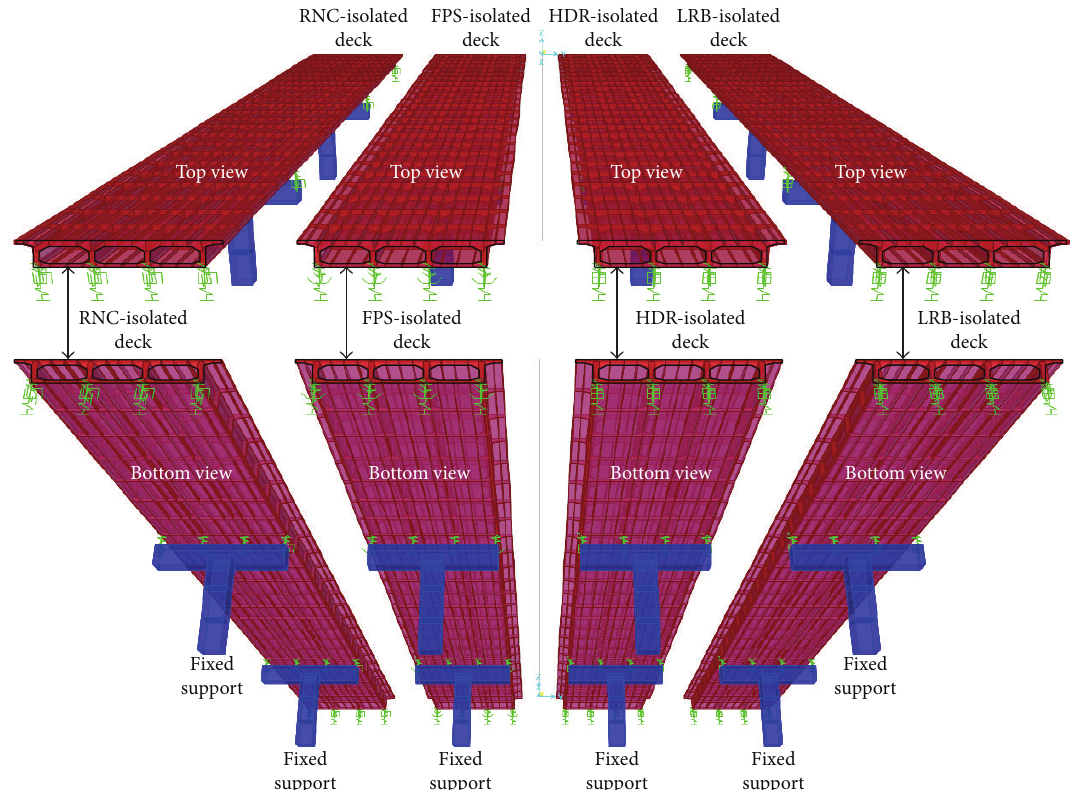
Figure 6: FE model of isolated identical bridges using RNC, FPS, HDR, and LRB isolation